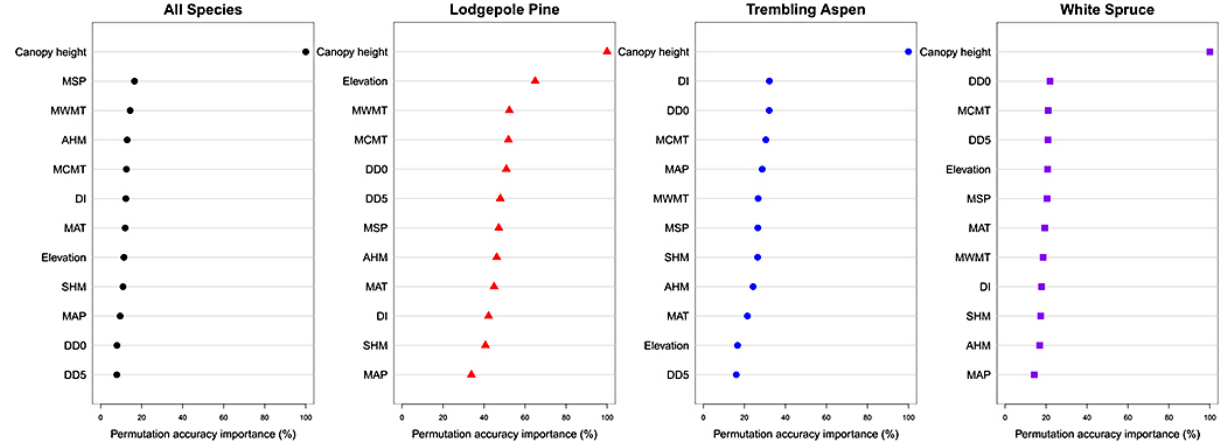
Figure 6. Relative importance of predictor variables for AGB estimation by decision-tree-based modeling with random forest algorithm. Variable importance is measured in mean decrease in accuracy, which is the decrease in accuracy of a classification after the variable has been randomly permuted. A higher mean decrease in accuracy means the variable contributes more to the accuracy of the classification. Table 5. AGB and total biomass estimations in previous